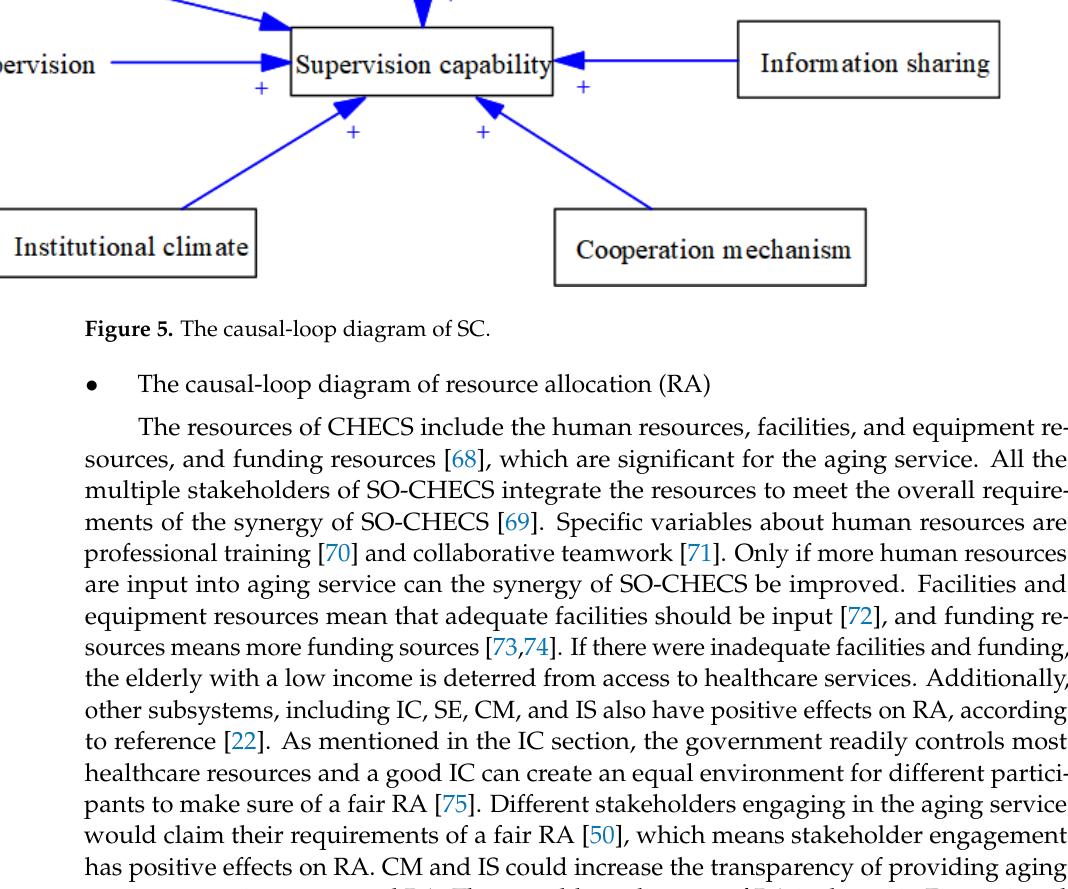
Figure 5. The causal-loop diagram of SC.